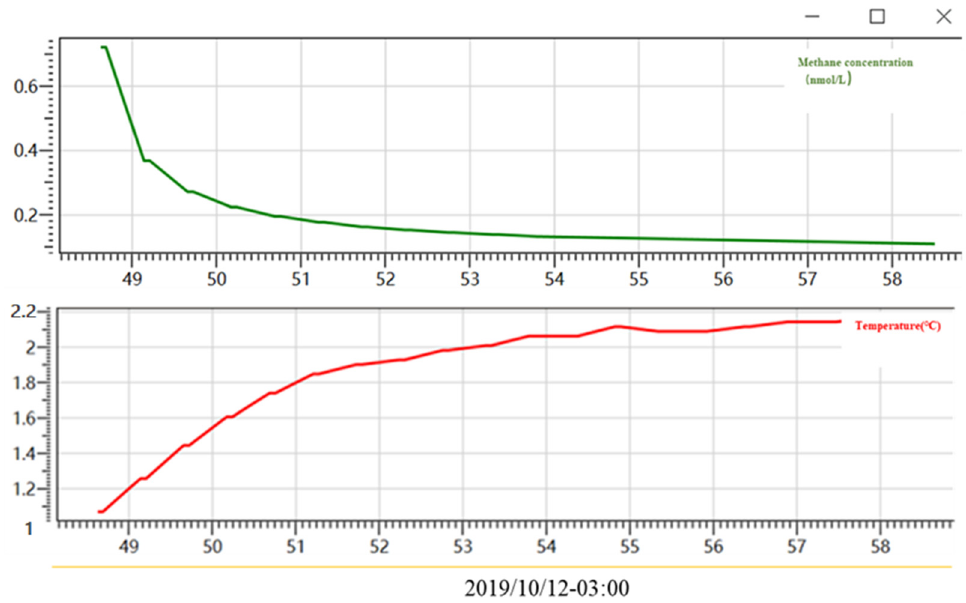
Figure 8. Test data at a water depth of 1250 m (18,264–18,187 sound communication module paired successfully).